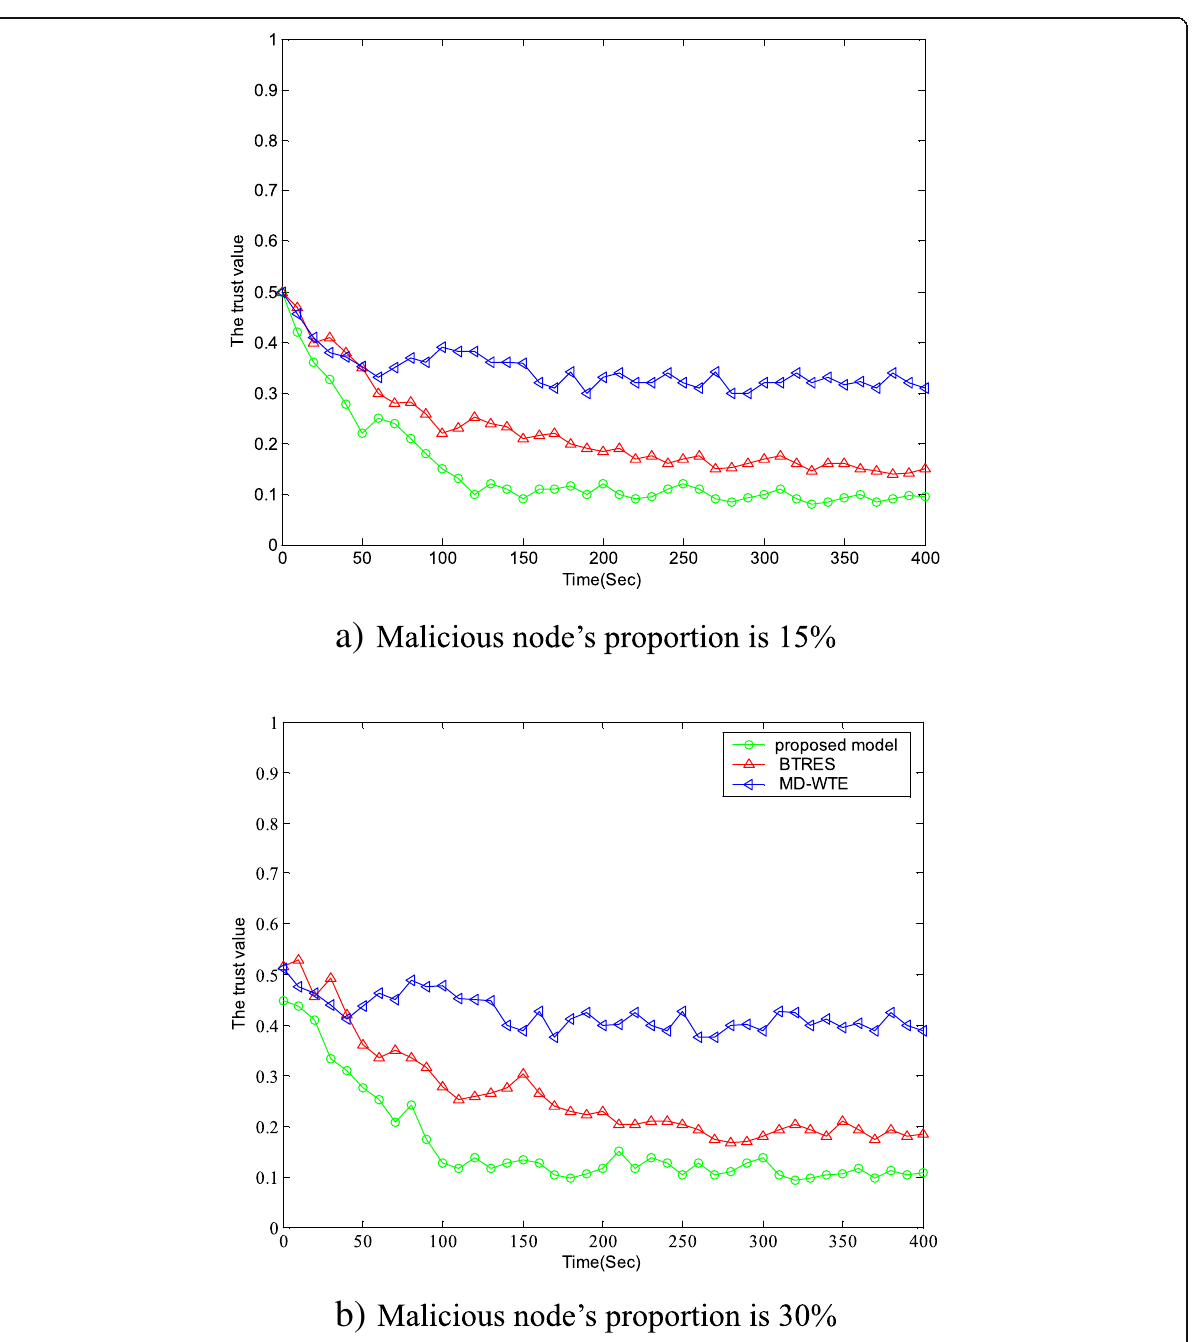
Fig. 2 The trust value of malicious node with time. a Malicious node ’ s proportion is 15%. b Malicious node ’ s proportion is